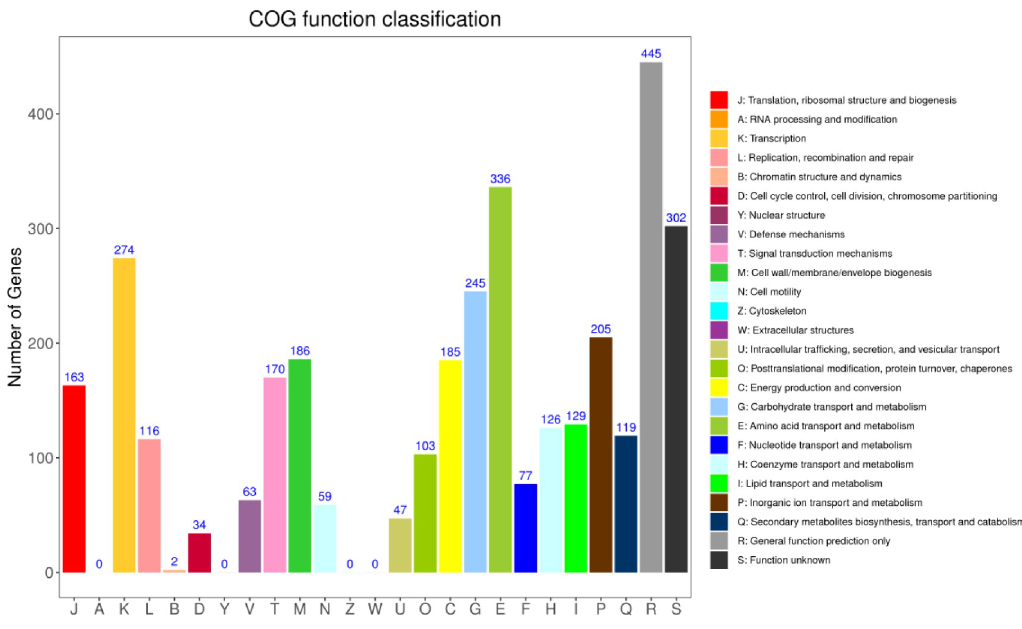
Fig 6. Functional classification of